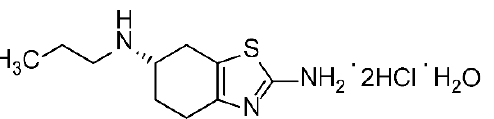
Figure 1. Chemical structure of pramipexole dihydrochloride monohydrate.